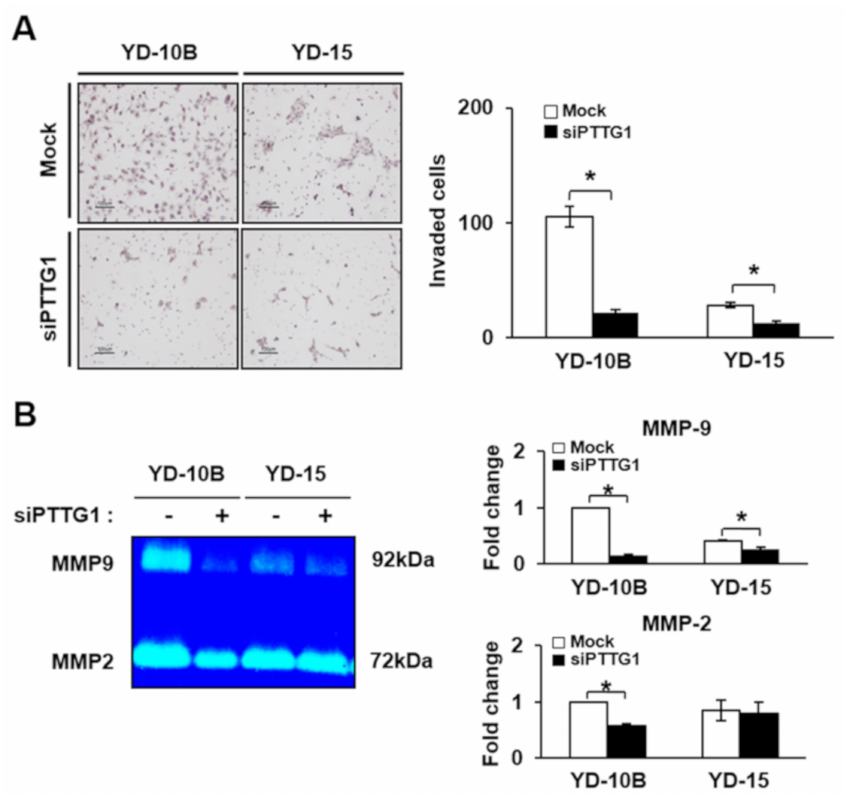
Figure 3. Invasion abilities of oral SCC cell linesdepend on PTTG1 expression. ( A )Image (left) and numbers (right) of invaded YD-10B and YD-15 cells after siPTTG1 treatment. Magnification, × 100; scale bar = 100 µ m. ( B ) Activities of MMP-9 and -2 in YD-10B and YD-15 cells after siPTTG1 treatment analyzed by zymography. The values are means ± standard errors. * indicates significant differences between control and siPTTG1 treatment ( p < 0.05). All experiments were performed in